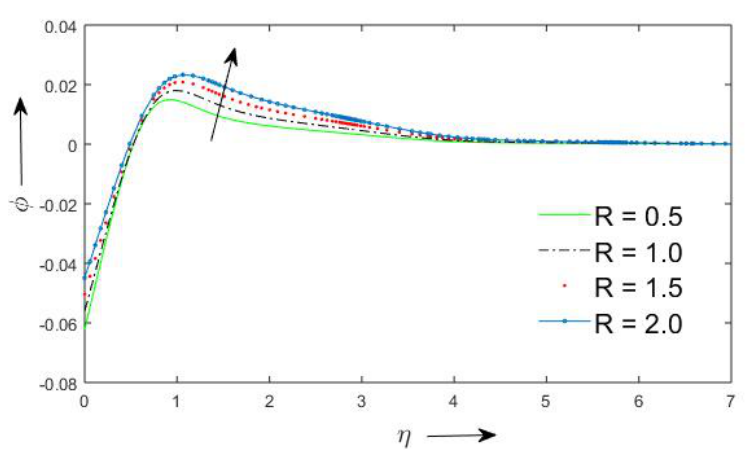
Figure 12: Changes in concentration as a consequence of